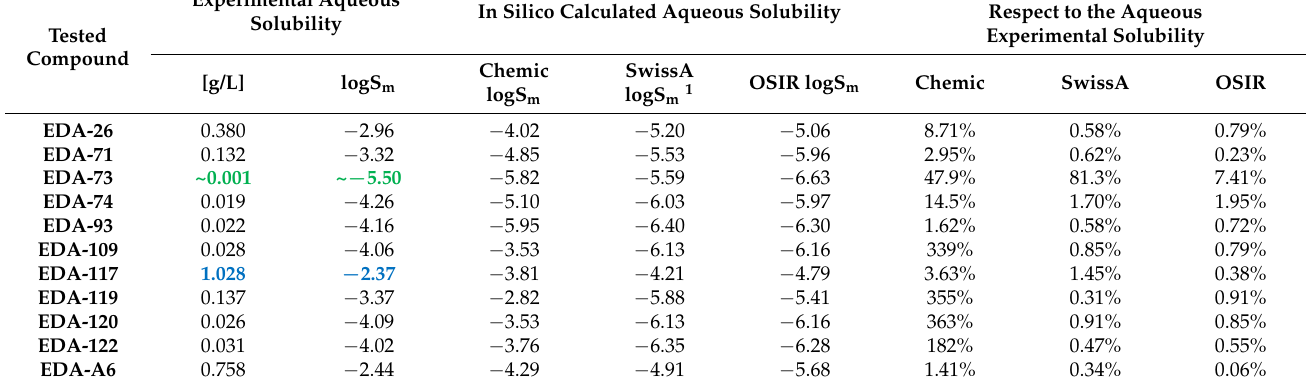
Table 1. Aqueous solubility determined using computational and experimental methods, as well as percentage that the predicted in silico solubility predicted in respect to the aqueous experimental solubility. In experimental values, green denotes almost insoluble compounds and blue denotes those compounds with solubility of more than 1